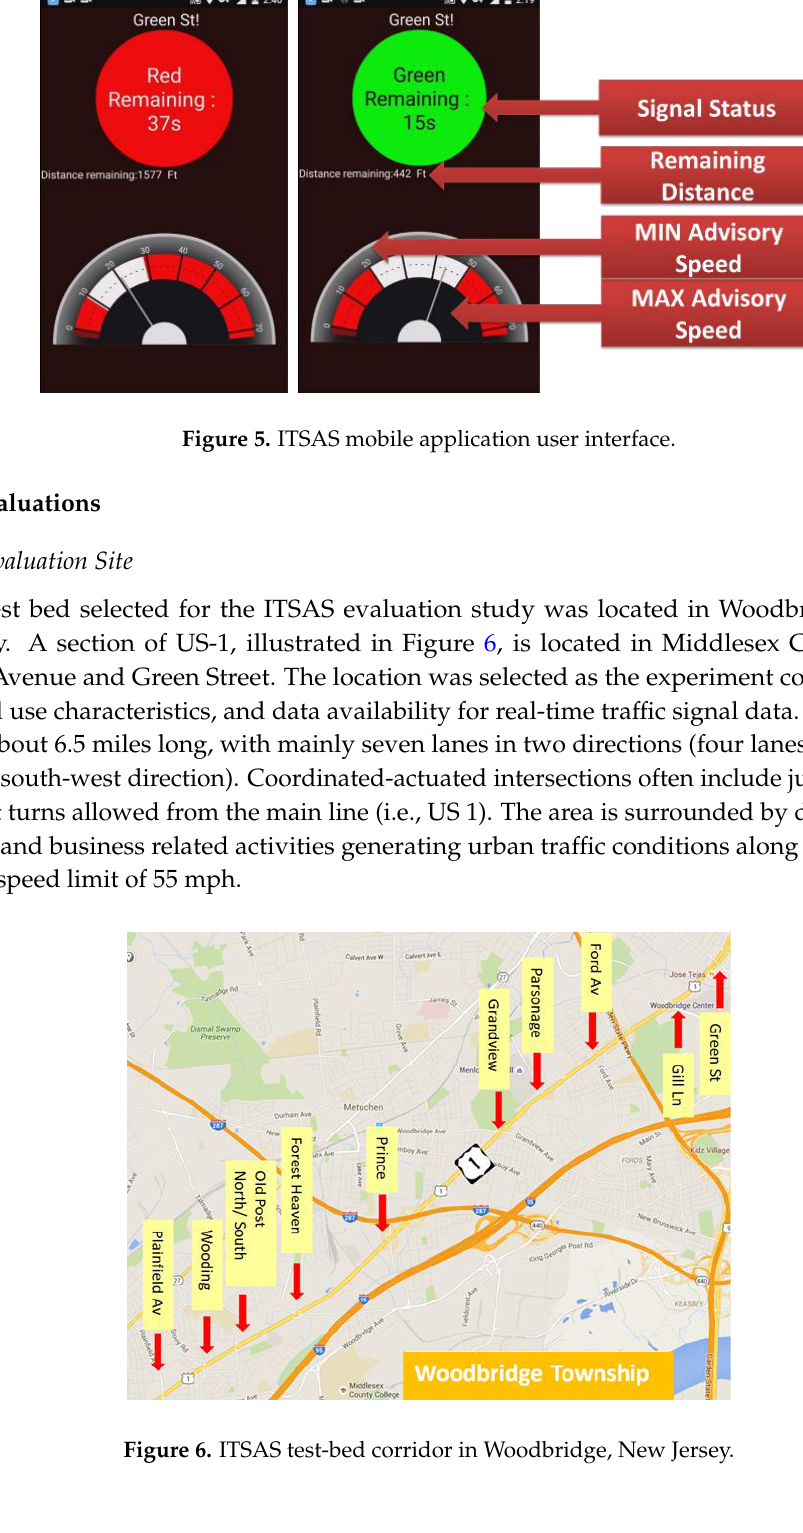
Figure 6. ITSAS test-bed corridor in Woodbridge, New Jersey.